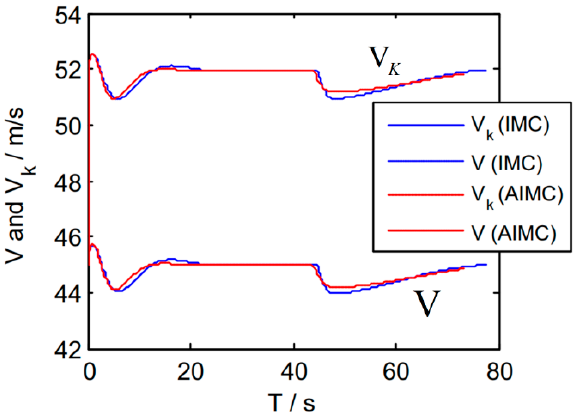
Figure 14. Hight in headwind conditions.